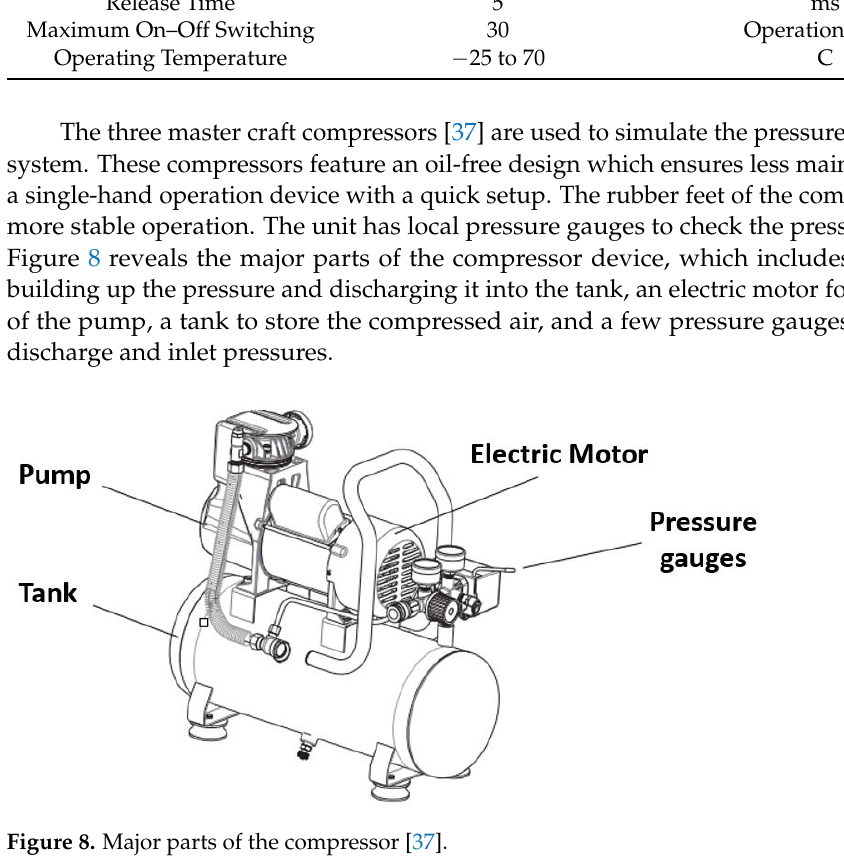
Table 7. Technical specifications of compressor [37].